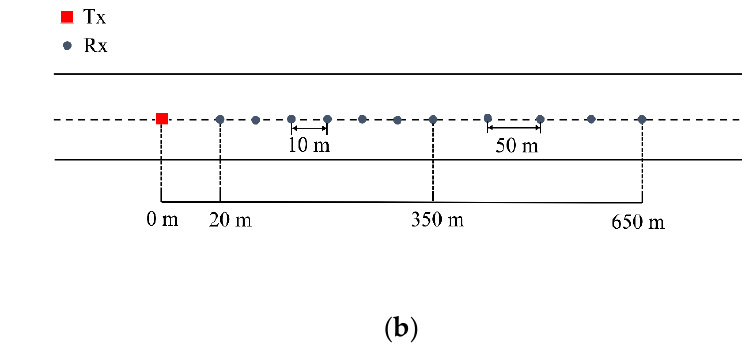
Figure 6. Transmitting and receiving antennas setting ( a ) The cross-section of the measurement tunnel; ( b ) the positions of T x and R x .